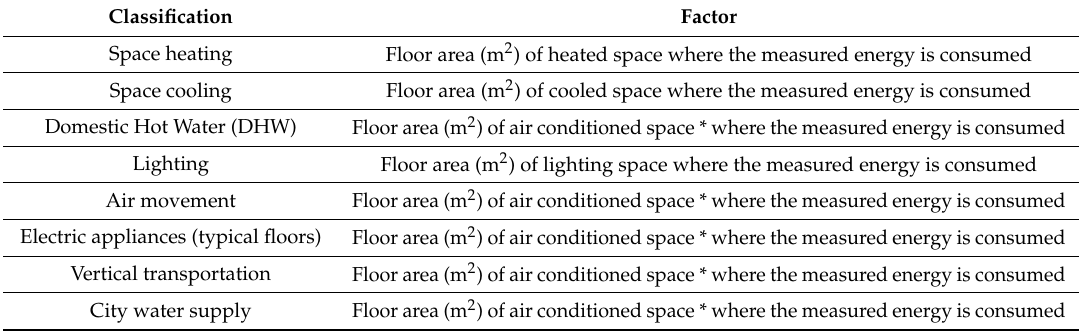
Table 11. Energy use intensities (EUIs)